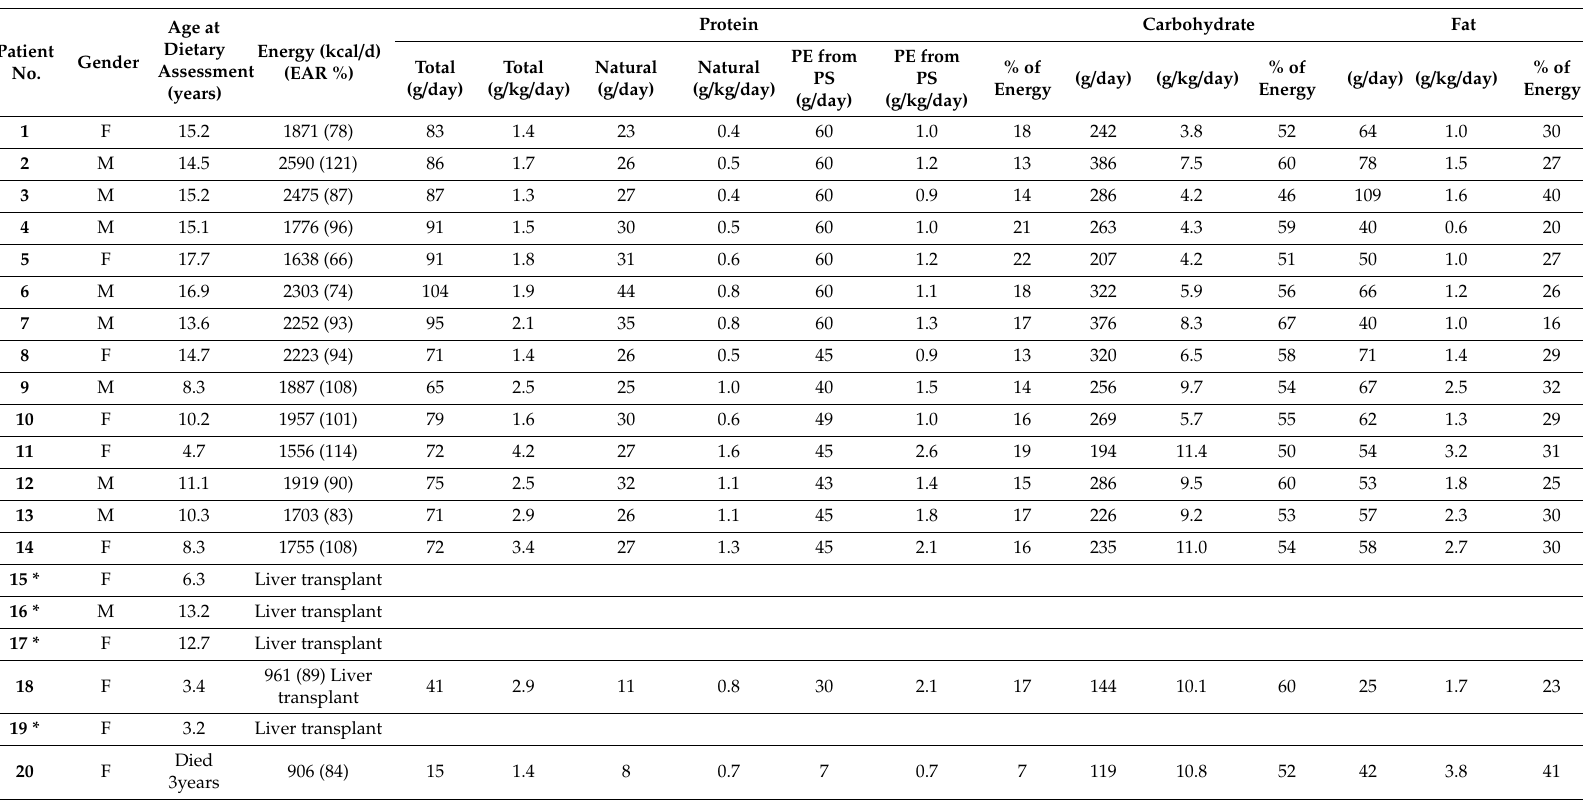
Table 4. Dietary intake of patients with HTI based on 24-h food recall at the final